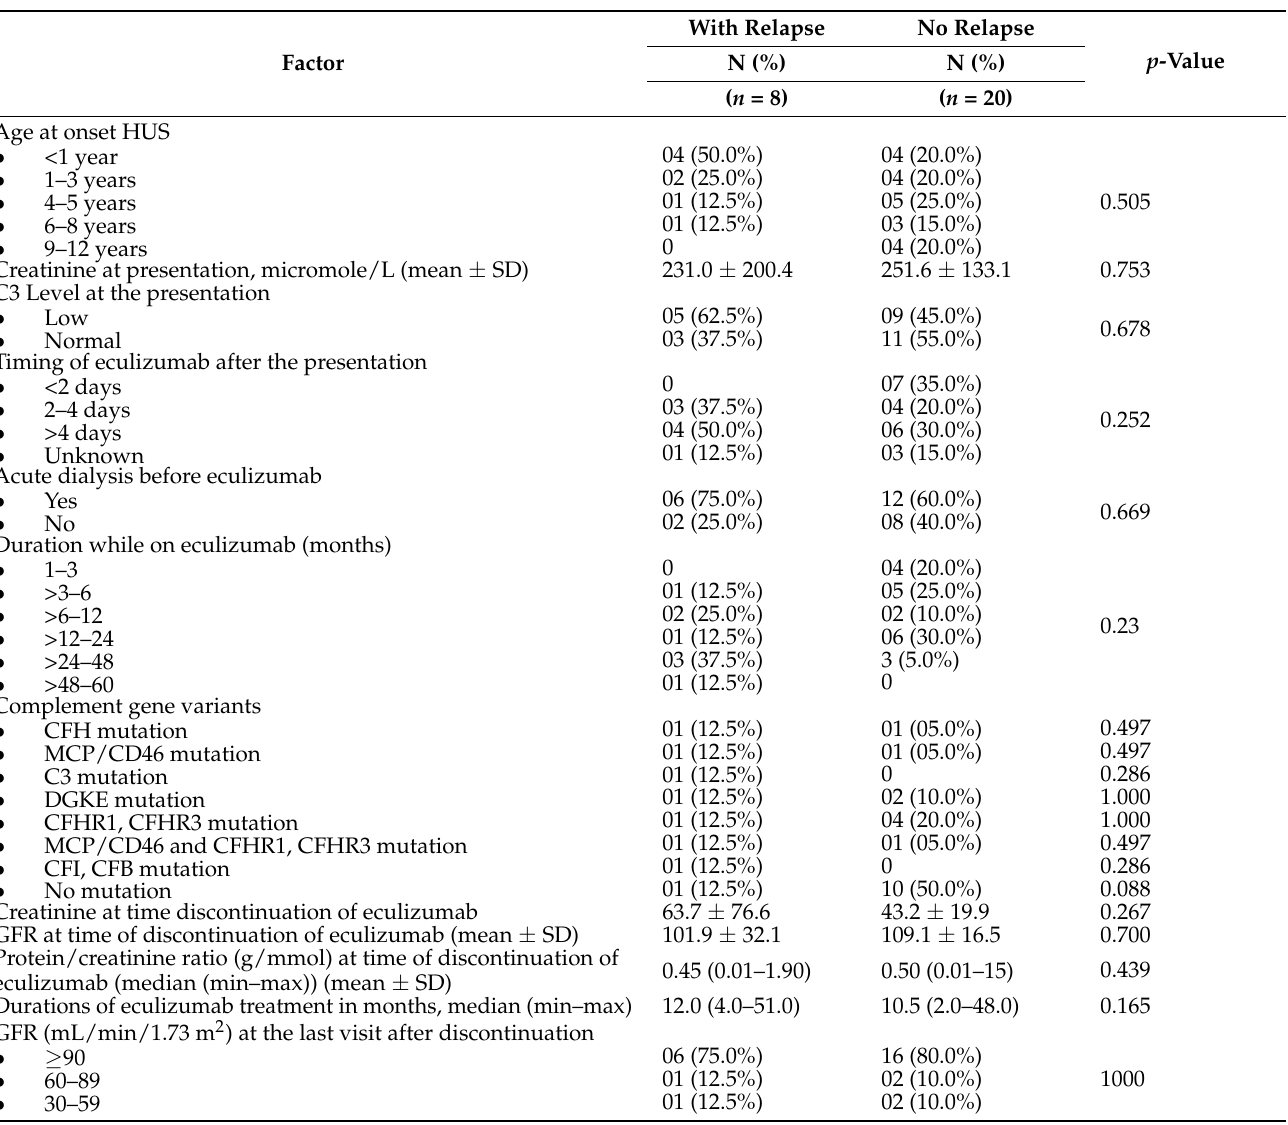
Table 3. Characteristics of patients who relapsed and patients who did not relapse before eculizumab discontinuation.